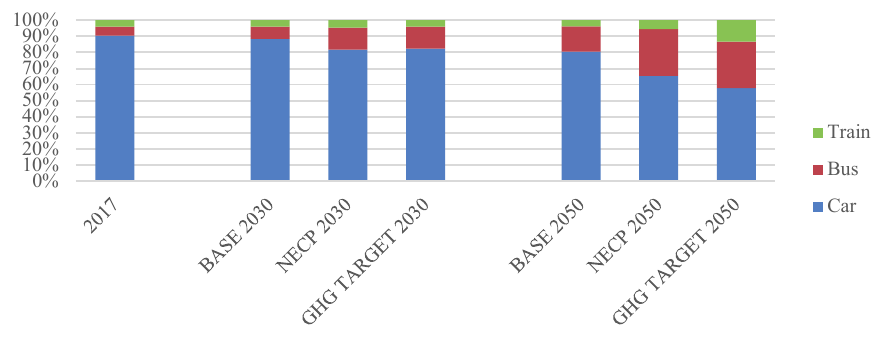
Fig. 17. Structure of modes of passenger transport for long distances.